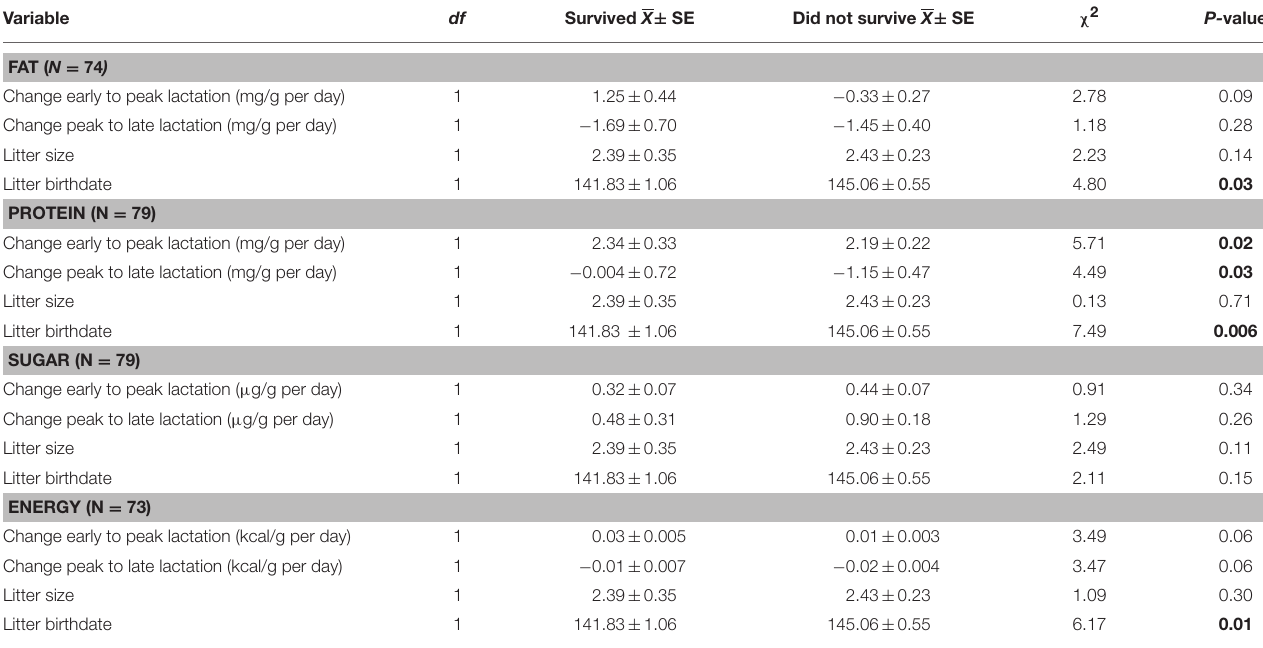
TABLE 3 | Effects of change in milk composition, reproductive timing, and litter size on the probability of juvenile survival overwinter. Variable